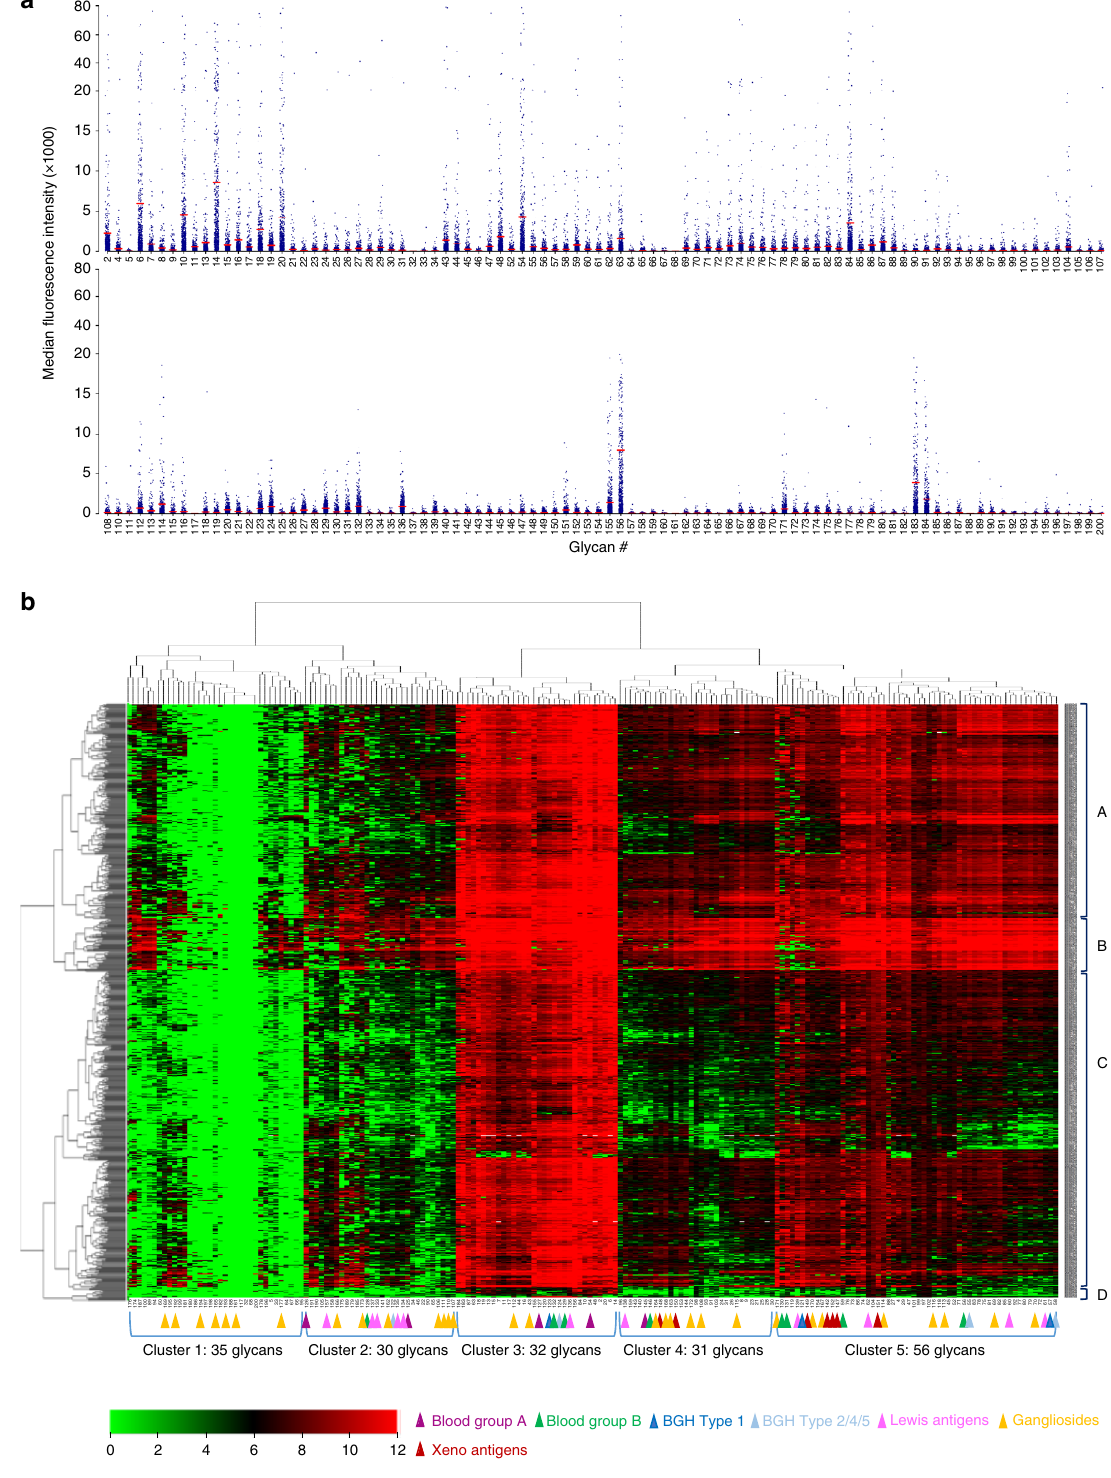
Fig. 5 Natural anti-glycan IgM antibodies in 613 human serum samples measured on MGBA. a Dot plots of anti-IgM antibody levels (MFI) for each glycan in 613 individuals. Each dot represents one individual and mean for each glycan is represented by the red line. Background-subtracted net MFI data (MFI×1000) on y -axis is expanded for 0 – 20,000 range to improve visualization. b Heatmap of anti-IgM antibody levels in 613 samples. The data are Log 2 transformed. Each row represents an individual sample and each column represents an individual glycan. IgM levels are represented by the color codes as indicated by the color bar. Serum IgM was used to cluster glycans (Cluster 1 – 5) as well as subjects (Cluster a – d ). Cluster A, B, C and D contain 221 (36%), 54 (8.8%), 325 (53.1%), and 13 (2.1%) subjects, respectively. The sample clusters are not associated with demographic or clinical variables such